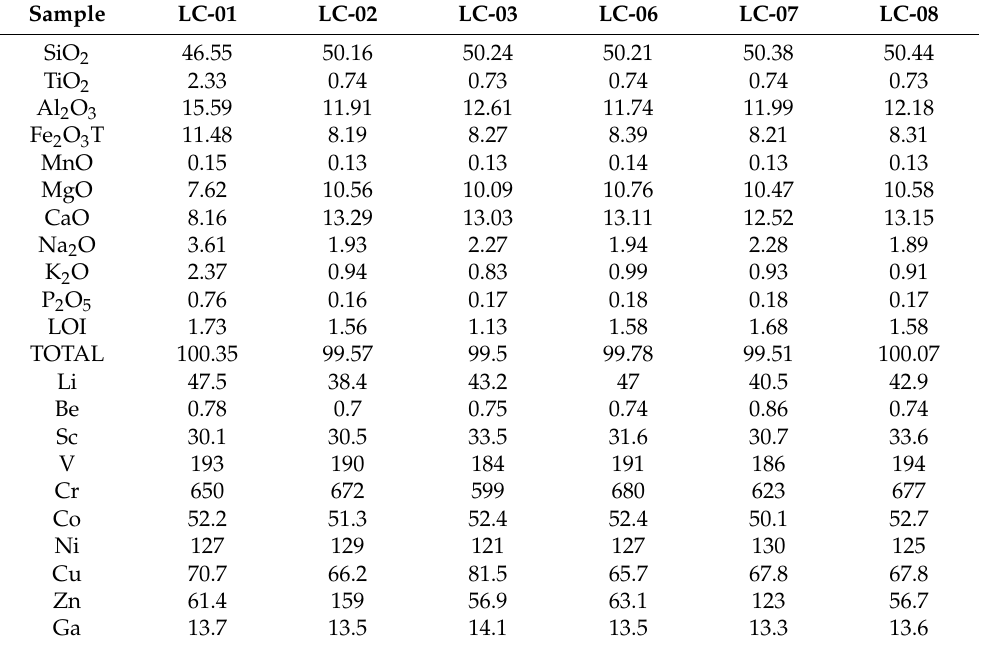
Table 1. Bulk-rock geochemistry for the Laocheng appinite from